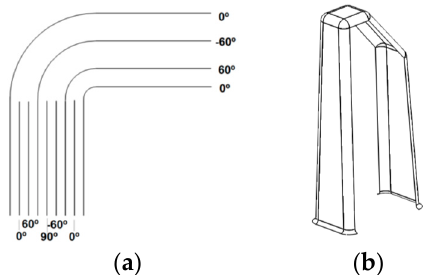
Figure 16. ( a ) Positioning of the additional carbon fabric layers; ( b ) pre-cut fabric for draping the additional 5 layers for the side walls.